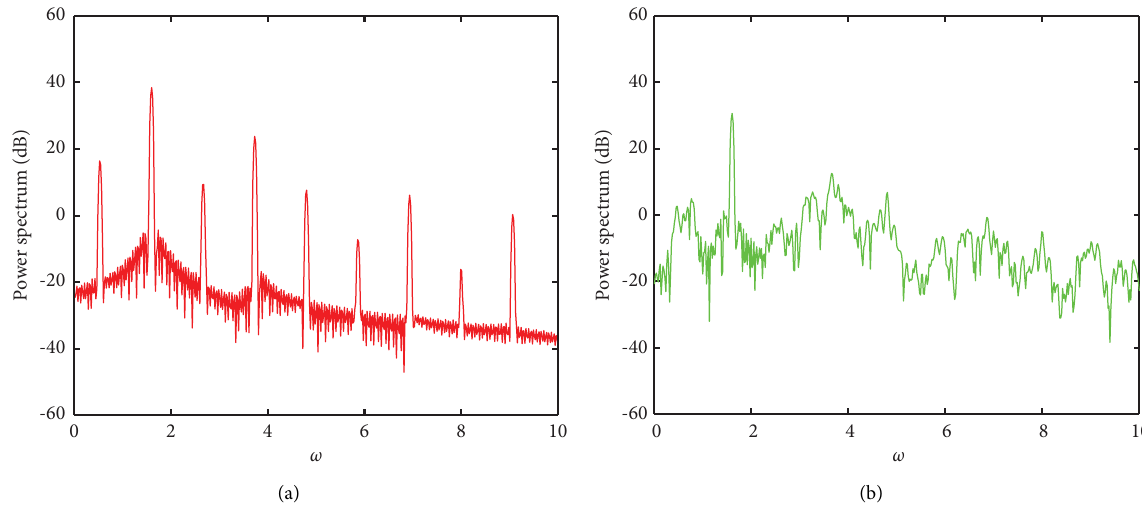
Figure 15: Te response power spectrum of the mechanical equipment. (a) No exerting the OLPNCL control. (b) Exerting the OLPNCL control.